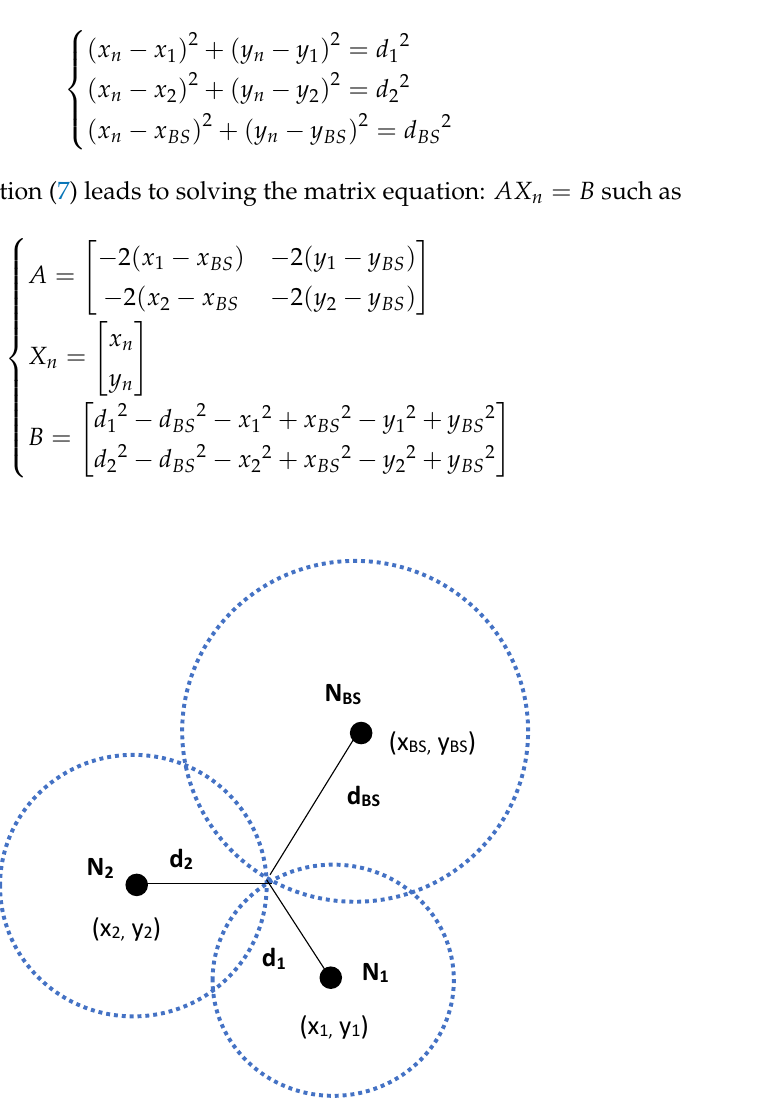
Figure 2. Network Coding for Enhanced Narrowband IoT (NB-IoT) nodes localization approach. After the geographical localization of nodes within the cell, the BS through its downlink reply packet does not only distribute the initial adaptive spread spectrum frequency hopping seed, it also sends information that geographically groups NB-IoT nodes that are close to each other into clusters. A typical illustration of a typical cluster formation within an NB-IoT cell is shown in Figure